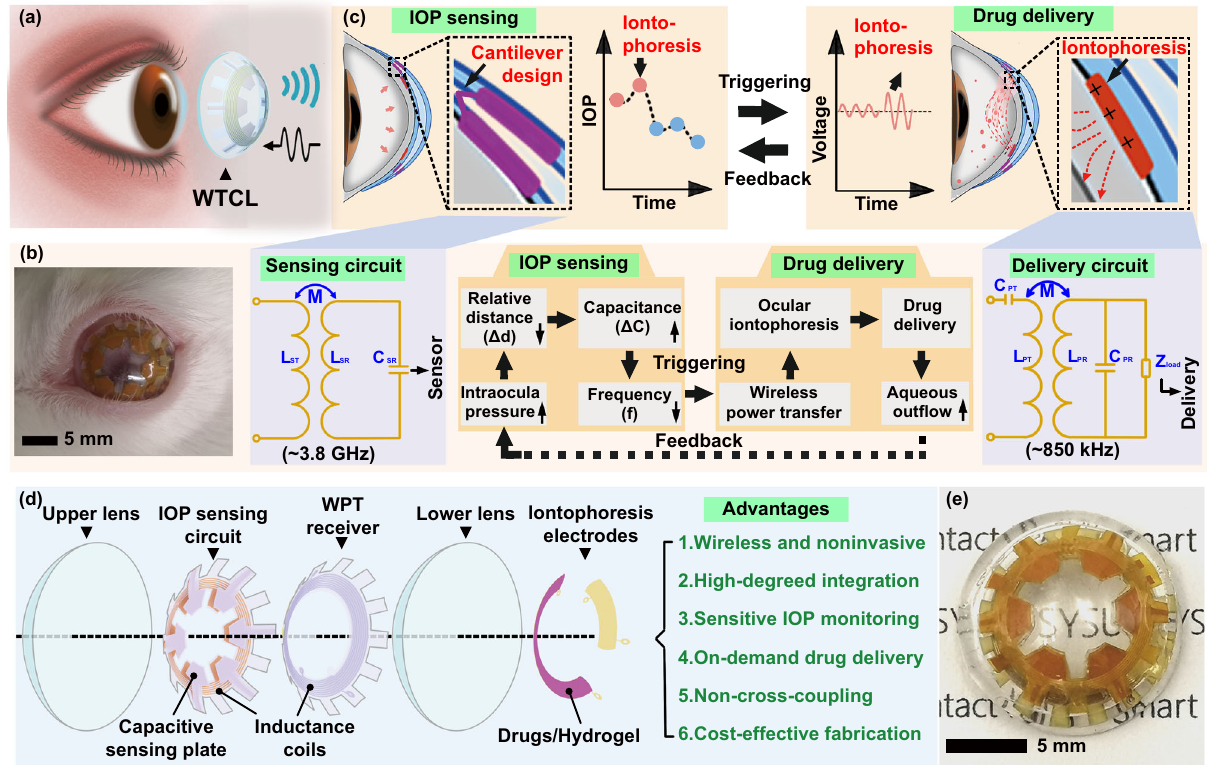
Fig. 1 Schematic of the WTCL for real-time and in situ IOP monitoring and drug administration. a Schematic of the WTCL for wireless IOP monitoring and administration. b Photograph of WTCL worn on the eyes of a live rabbit. c Schematic of wireless operation for the purpose of IOP monitoring and on- demand medicines administration in a minimally invasive manner. The soft device, engineered as a double-layer contact lens structure, was integrated with an LCR and a WPT receiver circuit. These modules were wirelessly connected to an external integrated antenna that could record the IOP signal and trigger iontophoresis for drug delivery if needed. Insert fi gures respectively highlight critical IOP sensing and drug delivery unit. d Structure of the WTCL in an exploded view. e Optical image of the